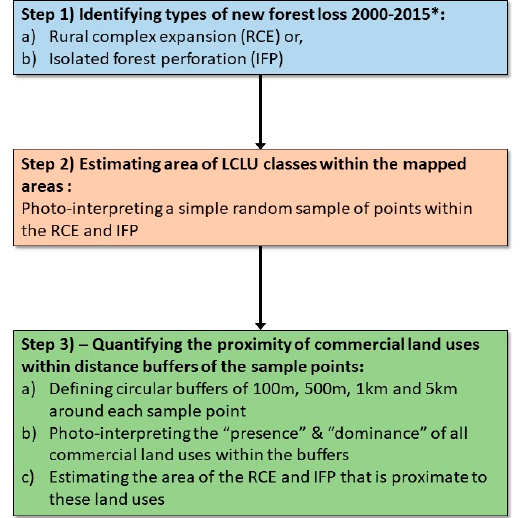
Figure 3. The methods of the paper can be summarized in three steps: Step 1) builds upon the map published by [13]. In [14], the area of each land cover and land use (LCLU) type within the established rural complex for 2000 was estimated; * Step 1 pertains to new forest loss during 2000–2015 that occurred outside of the established rural